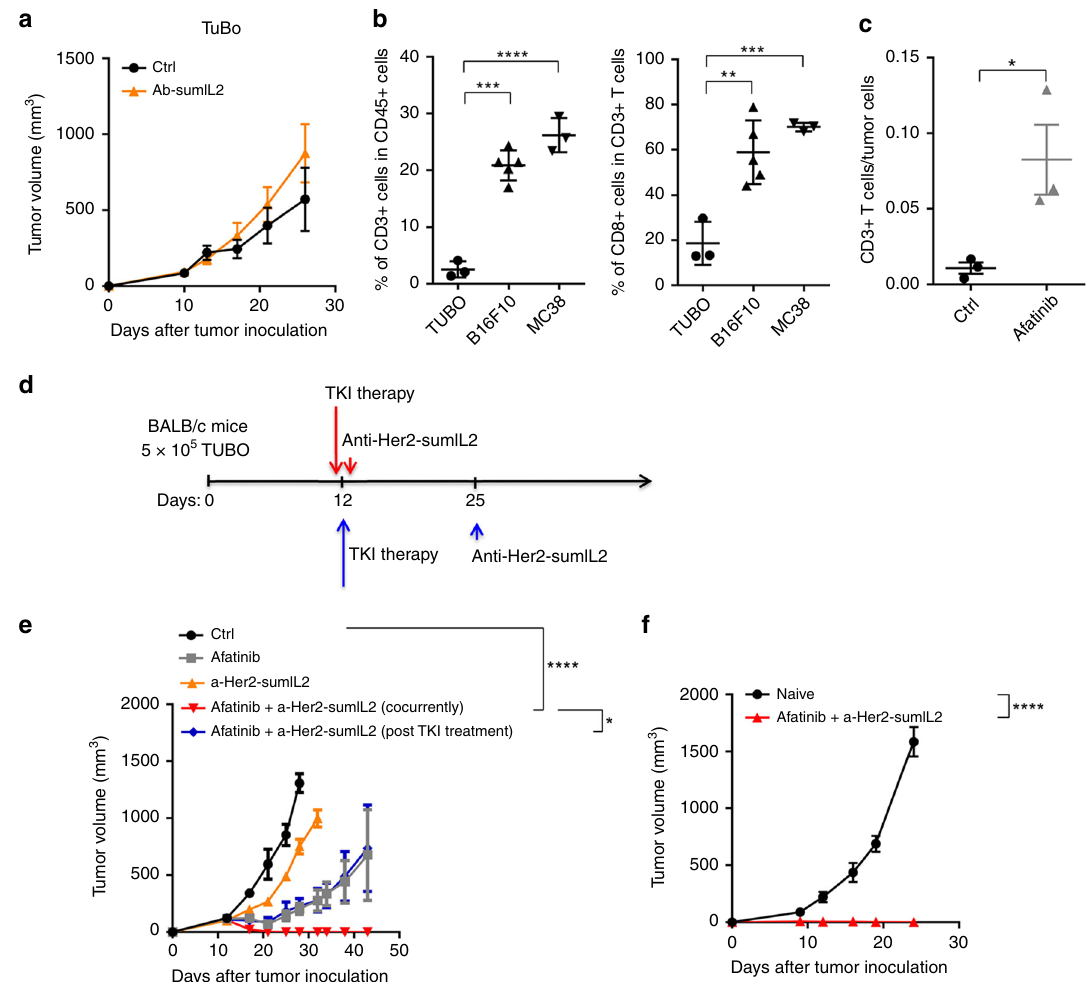
Fig. 5 First-line TKI therapy can synergize with sumIL-2 therapy to control cold tumor. a BALB/c mice ( n = 5 group) were inoculated subcutaneously with 5 × 10 5 of TUBO cells and then were i.v. treated with PBS or 10 μ g of Erb-sumIL2 on days 10, 13, and 17. b Indicated tumor tissues were collected on day 9 posttumor inoculation. The percentages of CD3 + among CD45 + cells (left) and CD8 + among CD3 + cells (right) were analyzed by fl ow cytometry. c BALB/c mice ( n = 3 – 5 group) were inoculated subcutaneously with 5 × 10 5 of TUBO cells and then were i.p. treated with PBS or 1 mg of afatinib. TUBO tumor tissues were collected on day 6 post afatinib single treatment. The percentage of CD8 + among CD3 + cells was analyzed by fl ow cytometry. d , e BALB/c mice ( n = 5 group) were inoculated subcutaneously with 5 × 10 5 of TUBO cells and then were i.p. treated with PBS or 20 μ g of anti-Her2-sumIL2 on either days 12, 15, and 18 or days 25, 28, and 31. For TKI therapy, mice were treated orally with 1 mg of afatinib on days 12 and 17. The tumor growth was measured. f WT BALB/c mice or mice with tumor clearance by afatinib and anti-Her2-sumIL2 were injected subcutaneously with 3 × 10 6 TUBO cells. The growth of tumor was measured and compared twice a week. Two way ANOVA tests were used to analyze the tumor growth data. Unpaired T-tests were used to analyze the other data. ns (not signi fi cant), * P < 0.05, ** P < 0.01, *** P < 0.001, and **** P < 0.0001. One of the two or three